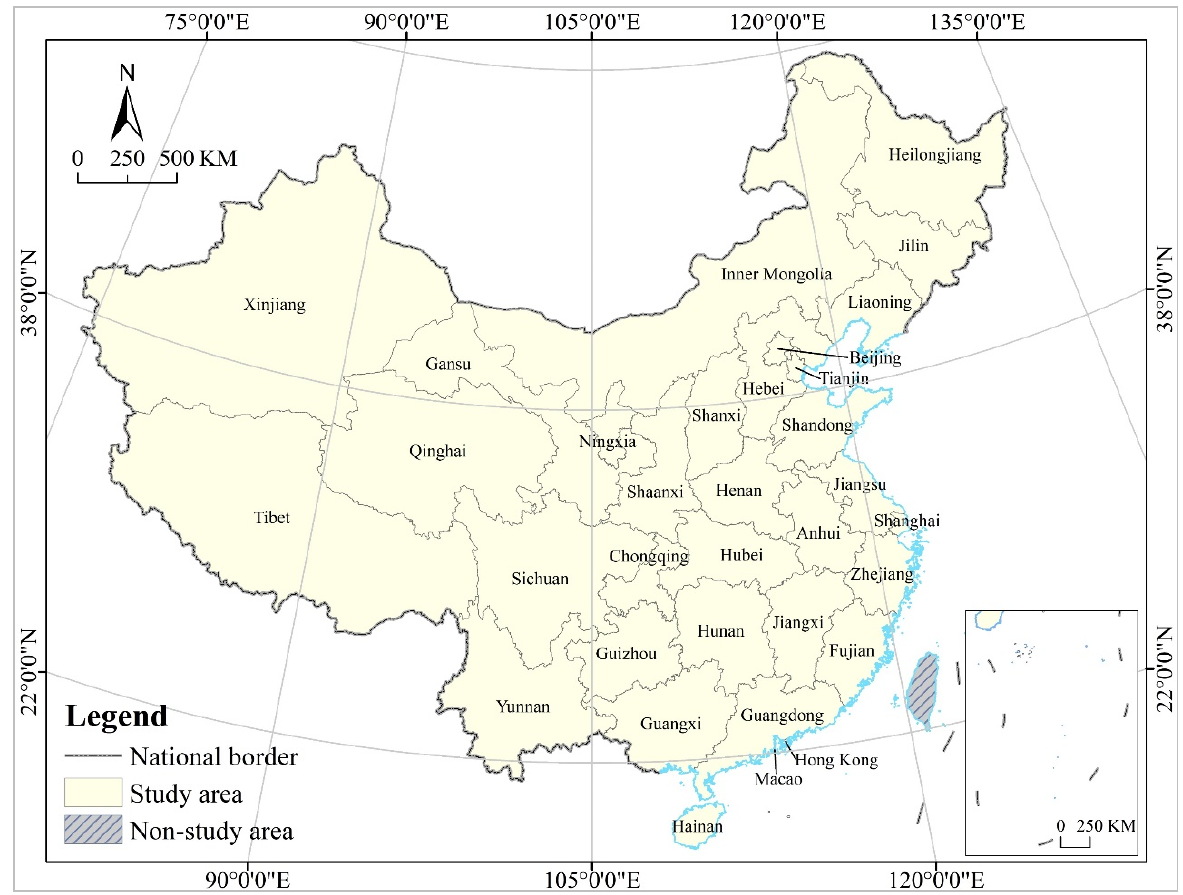
Figure 1. Study area.